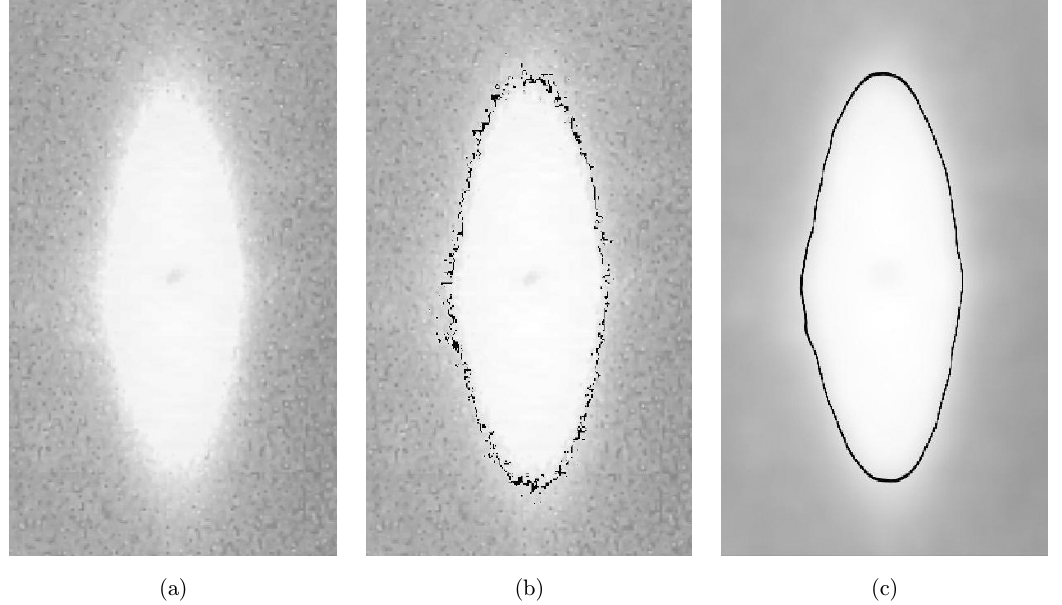
Fig. 7. Example of digital processing of an experimentally obtained di®raction pattern: original image (A); an isointensity line (B); the same line after smoothing